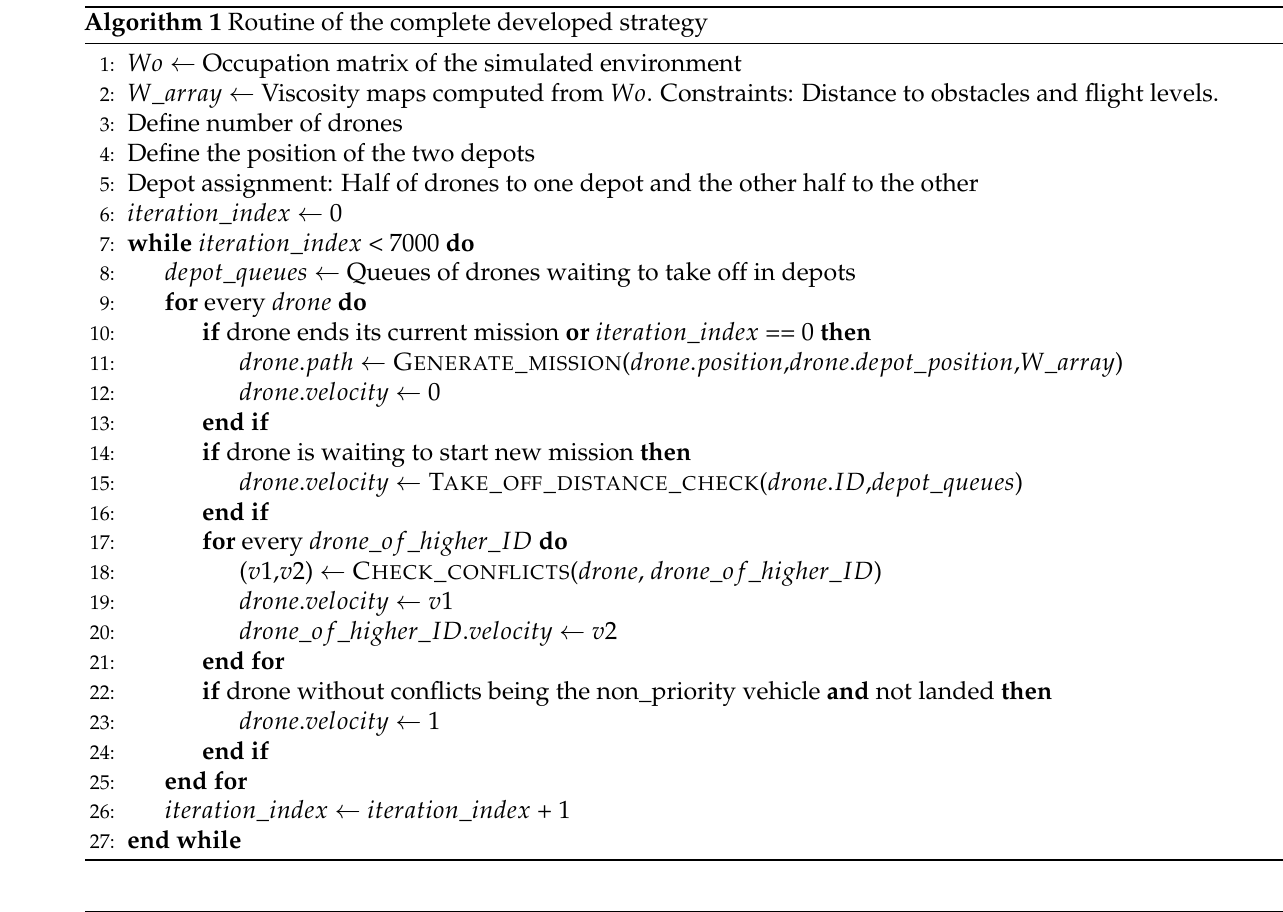
Algorithm 1 Routine of the complete developed strategy